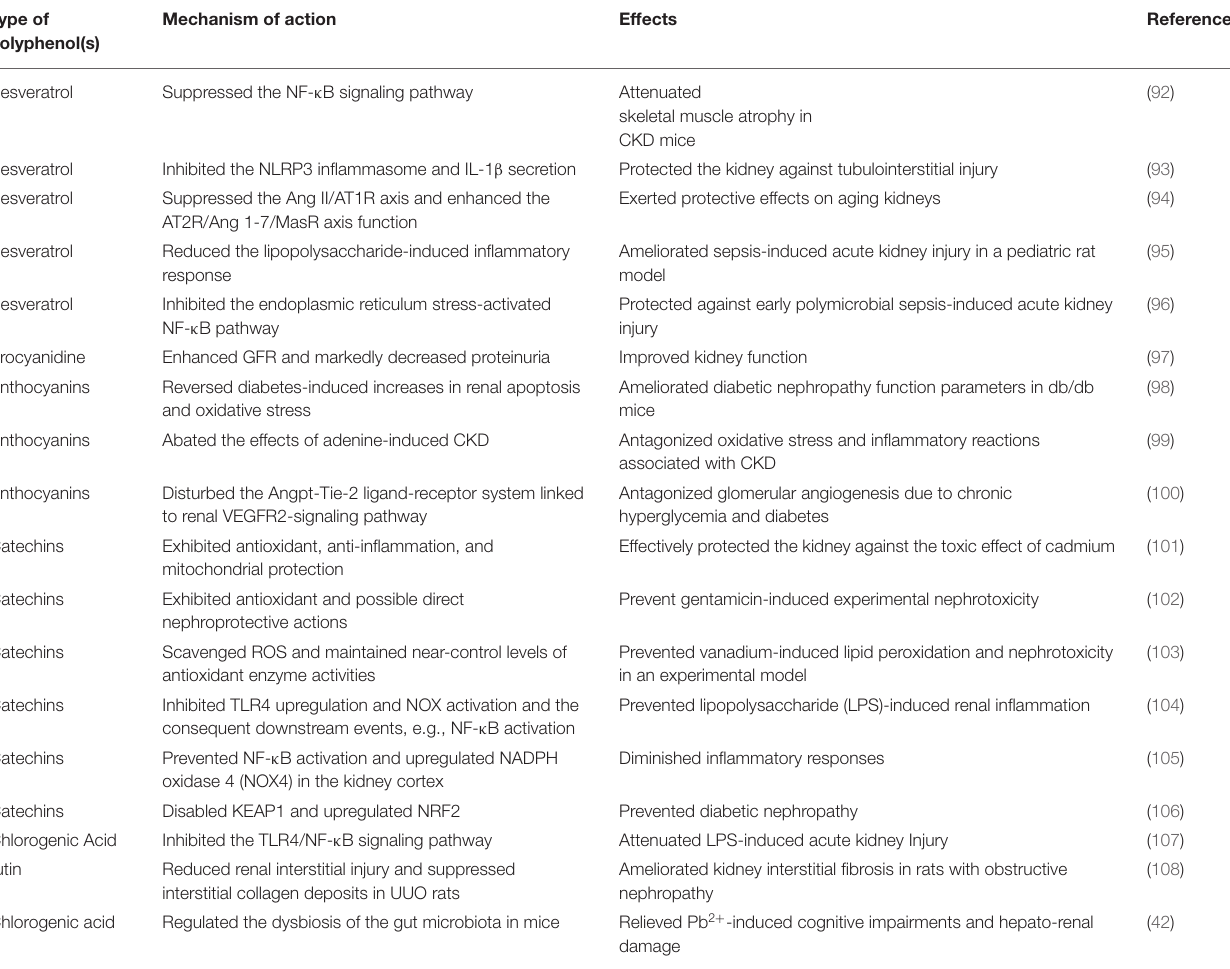
TABLE 2 | Effects of various types of polyphenols on CKD observed in recent